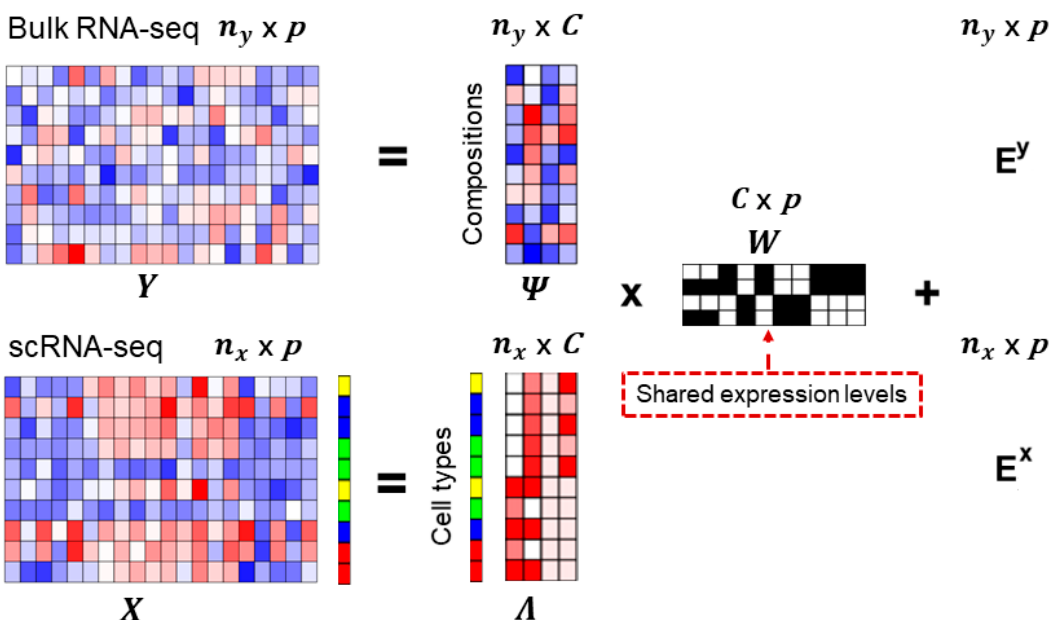
Figure 1. Overview of Multi-Omics Matrix Factorization (MOMF) framework. MOMF integrates bulk RNA-seq data and scRNA-seq data, to deconvolute the two expression matrices by the shared information and estimate the cell-type proportions for each individual. Specifically, MOMF jointly models both bulk RNA-seq count matrix Y and scRNA-seq count matrix X to infer the cell compositions Ψ of bulk RNA-seq data and low-rank matrix Λ of scRNA-seq data via matrix factorization, i.e., Y = Ψ W + E y and X = Λ W + E x , where W is the common shared gene expression levels and E y and E x represent the residual errors for bulk RNA-seq data and scRNA-seq data, respectively. The heatmaps are used to illustrate the gene expression level ( Y and X ) ; cell specific expression levels (bulk RNA-seq: Ψ ; scRNA-seq: Λ ) ; and gene specific expression levels ( W ) . The color bar along with the heatmaps of scRNA-seq data represents the cell types. n y is the number of individuals; n x is the number of cells; p is the number of common shared genes; 𝐶 is the number of cell types.